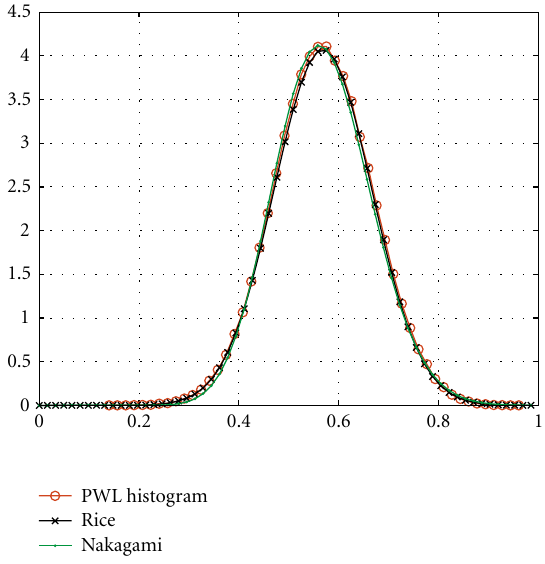
Figure 5: Approximation of the PDF associated to the PWL by a normalized root-square-energy histogram ( K = 3, φ = 0 . 1, β = 10).